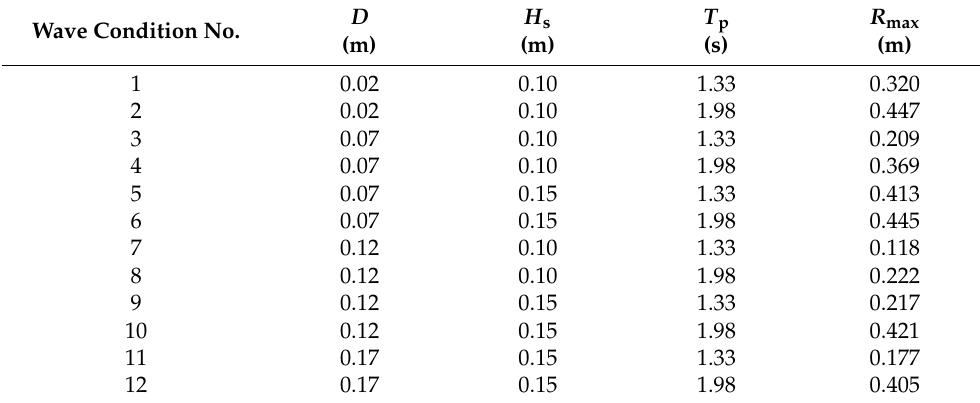
Table 5. Parameters of selected tested random wave conditions. Wave Condition